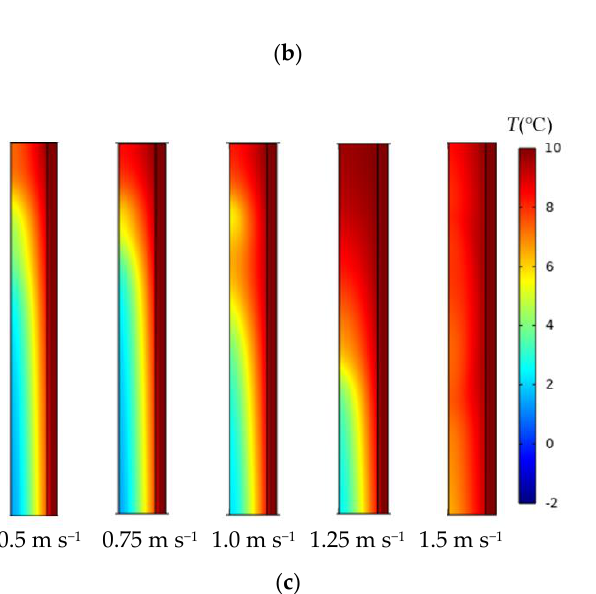
Figure 13. ( a ) Variations of the outlet water temperature with time in the ice melting process. Profile of the outlet water temperature ( b ) at 2.5 h and ( c ) 3.0 h under different fed water velocities from the main pipe